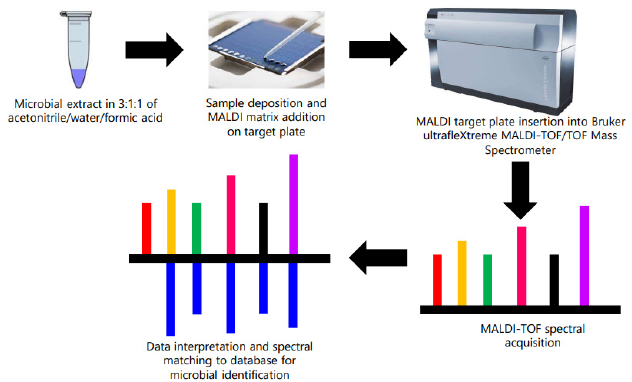
Figure 1. Schematics of identification of contaminating microorganisms using MALDI-TOF/TOF.